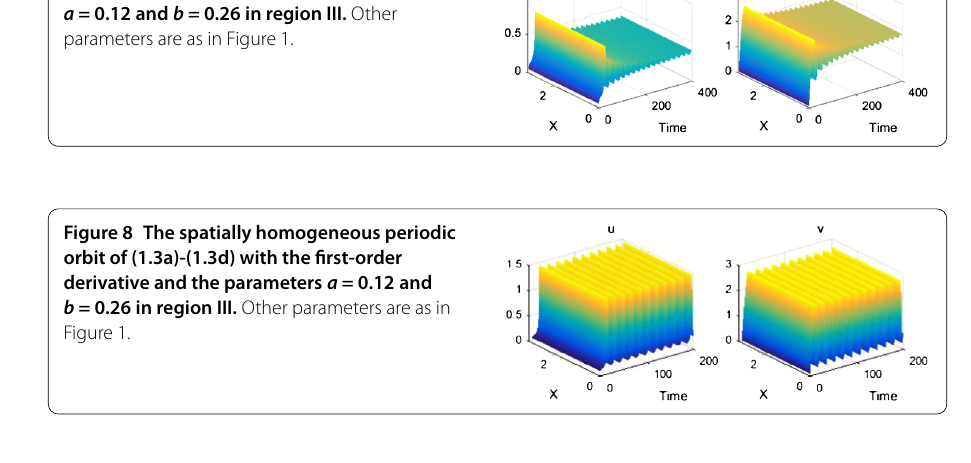
Figure 9 The stability of the spatially homogeneous steady state for (1.3a)-(1.3d) with the first-order derivative and the parameters a = 0.14 and b = 0.54 in region IV. Other parameters are as in Figure 1.